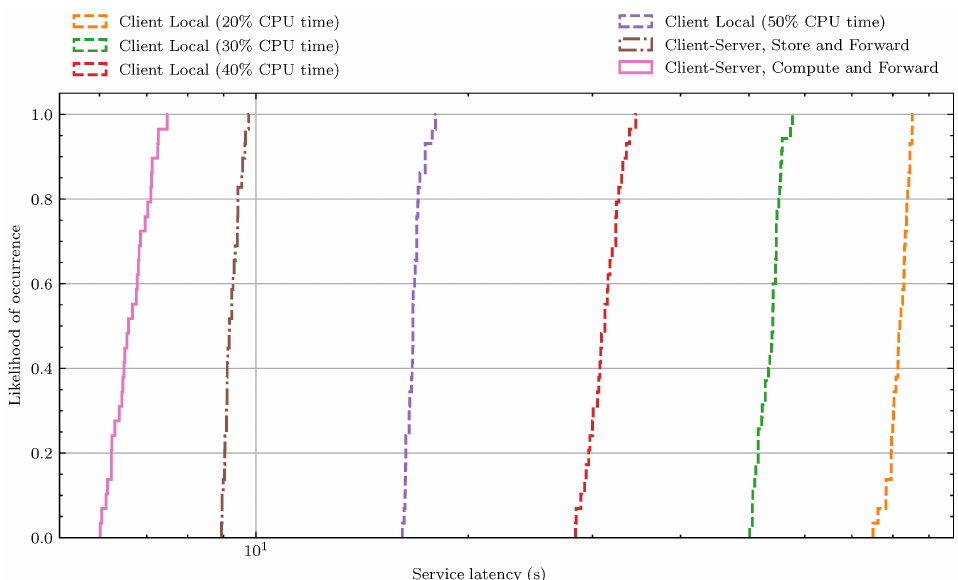
Figure 8. Overall service latency times for YOLOv2 object detection for on-client (with client com- putation resources equal to 20–50% server resources), traditional store-and-forward of image data to the server for object detection, and service split between in-network computing and forwarding to